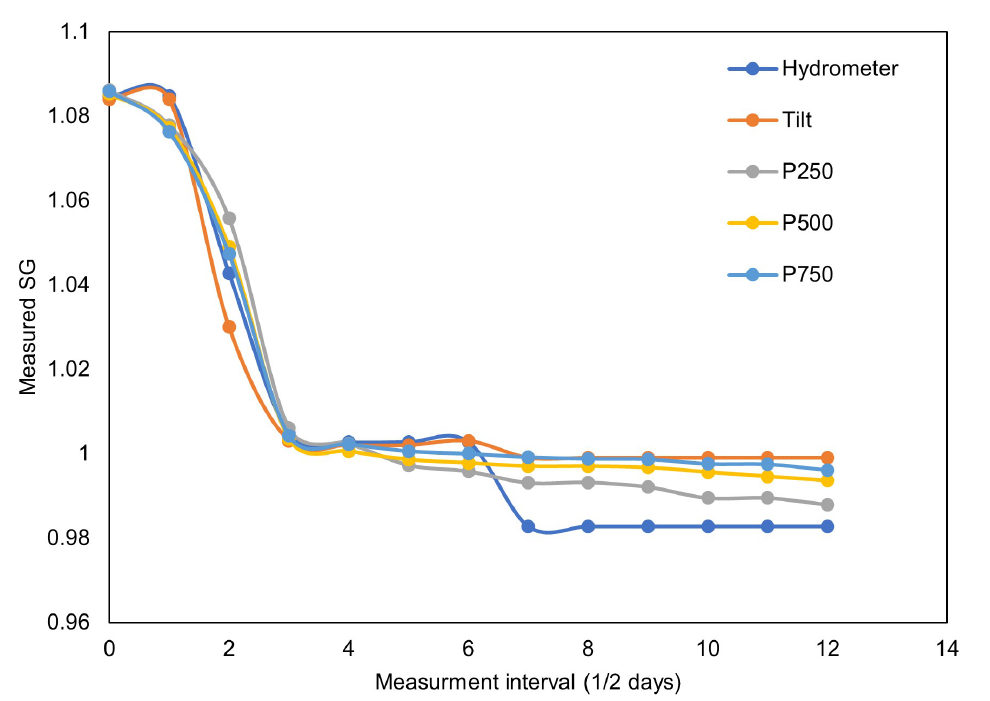
Figure 9. Specific gravity of the fermentation solution measured with a traditional hydrometer, Tilt hydrometer, and the proposed Brix sensor having pressure sensors 250 mm, 500 mm, and 750 mm apart.